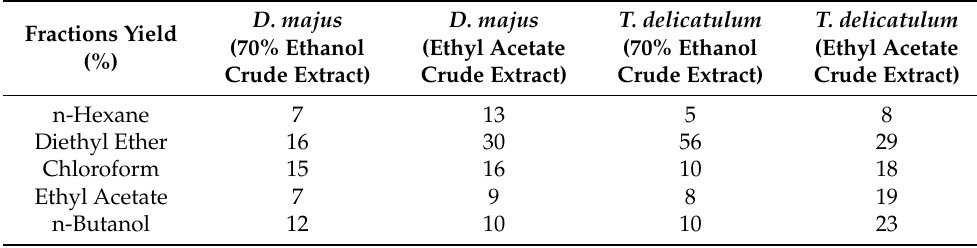
Table 1. Fractions yield (%) of bioactive crude